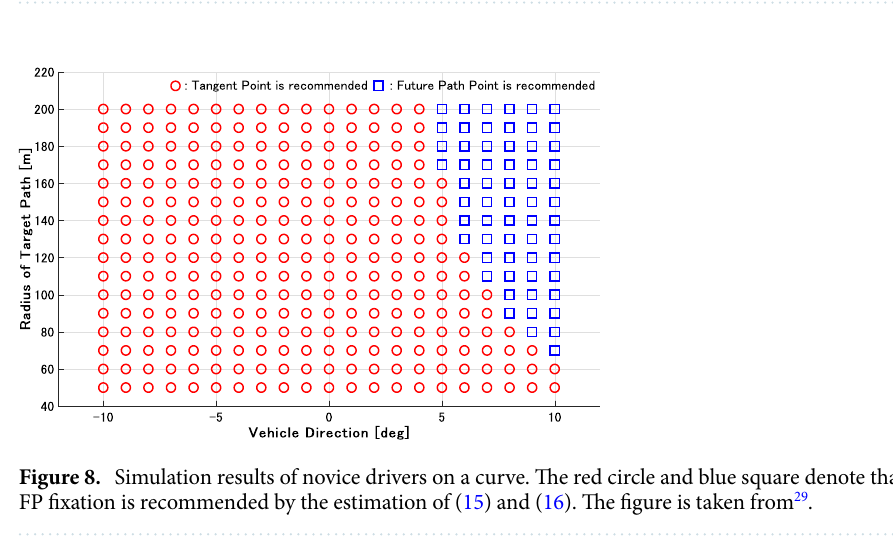
Figure 7. Simulation results of ordinary drivers on a curve. The red circle and blue square denote that the TP and FP fixation is recommended by the estimation of (14) and (16). The figure is taken from 29 .